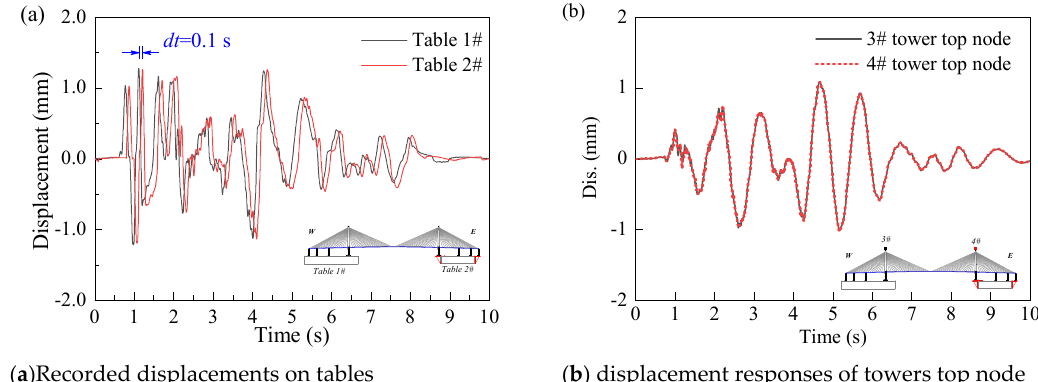
Figure 25. Responses recorded under time delayed excitation of ScEL ( dt = 0.1 s).